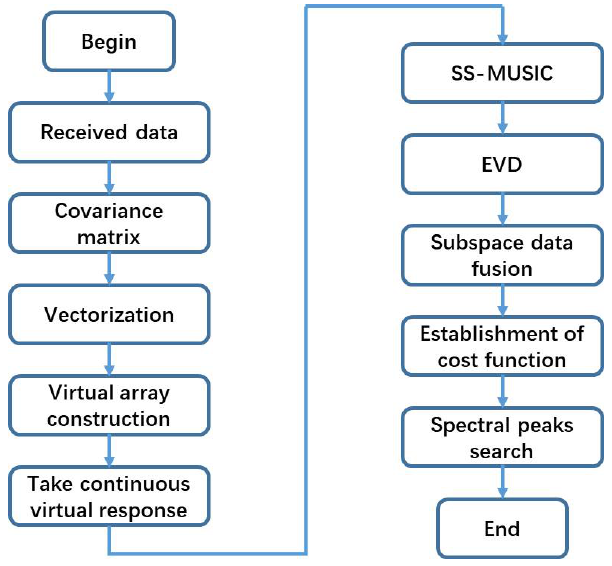
Figure 5. Flowchart of the proposed algorithm.